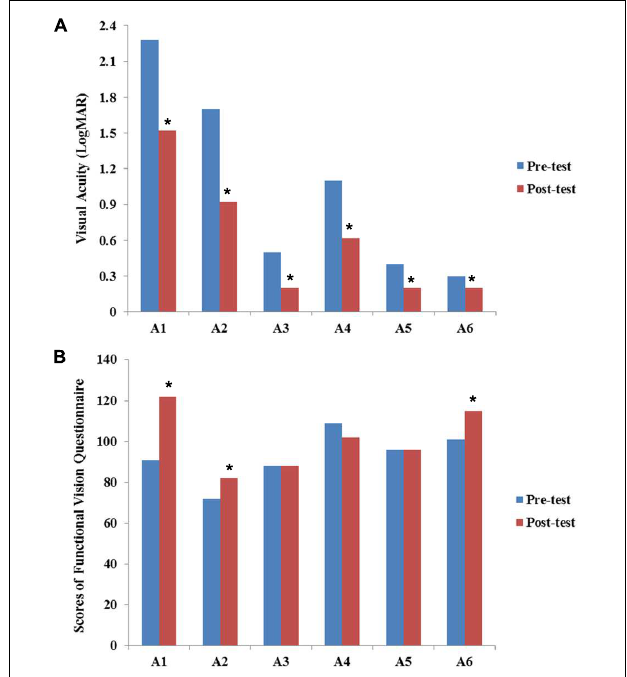
FIGURE 1 | Results of visual acuity (A) and functional vision (B) before and after the VS program. Values of visual acuity and functional vision assessment are individually presented for six participants (A1–A6). Data are presented for pre-training (blue bars) and post-training (red bars). The scores of visual acuity are transferred and expressed in LogMAR scale. All participants showed improvement in VA after visual training. Statistical analysis also revealed significant differences between pre-VS and post-VS [ Z = –2.20, asymptotic significance (2-tailed) = 0.028]. The Chinese version of the functional vision questionnaire was used to assess functional vision (full score = 140 points). Although some participants showed improvement in functional vision, no statistically significant difference was found [ Z = –1.46, asymptotic significance (2-tailed) = 0.144]. Asterisk ( ∗ ) indicates improvement in the scores of VA and functional vision after VS program.